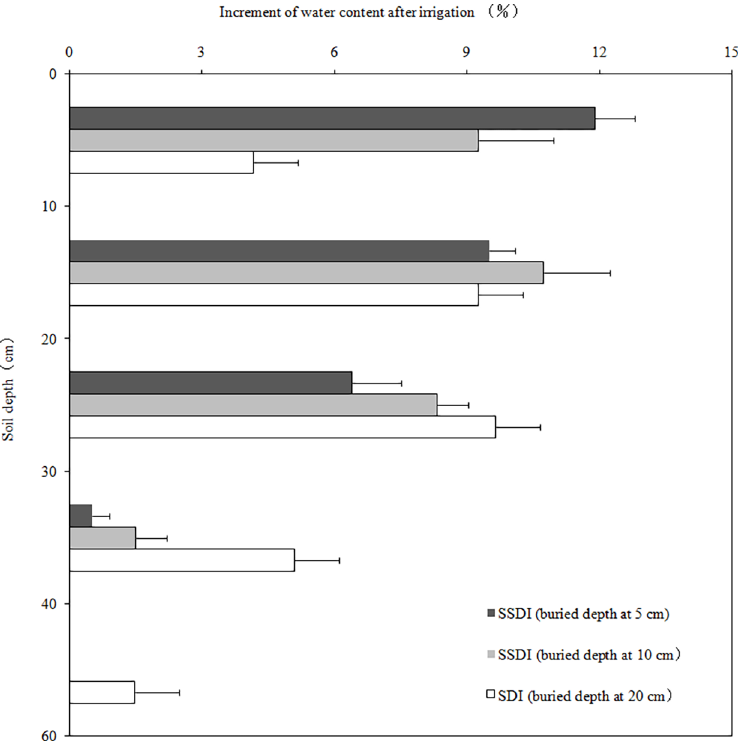
Fig 1. Increment of water content in different soil layers the day after